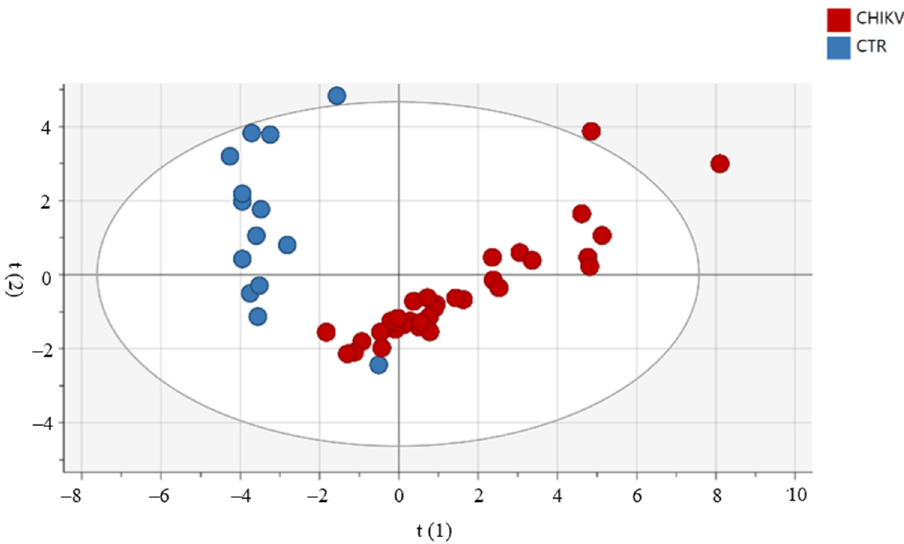
Figure 3. Principal component analysis reveals that the profile of inflammatory mediators in chil- dren exposed to maternal CHIKV infection is distinct from the control group. The Hotelling ellipse represents the 95% confidence interval for the model.